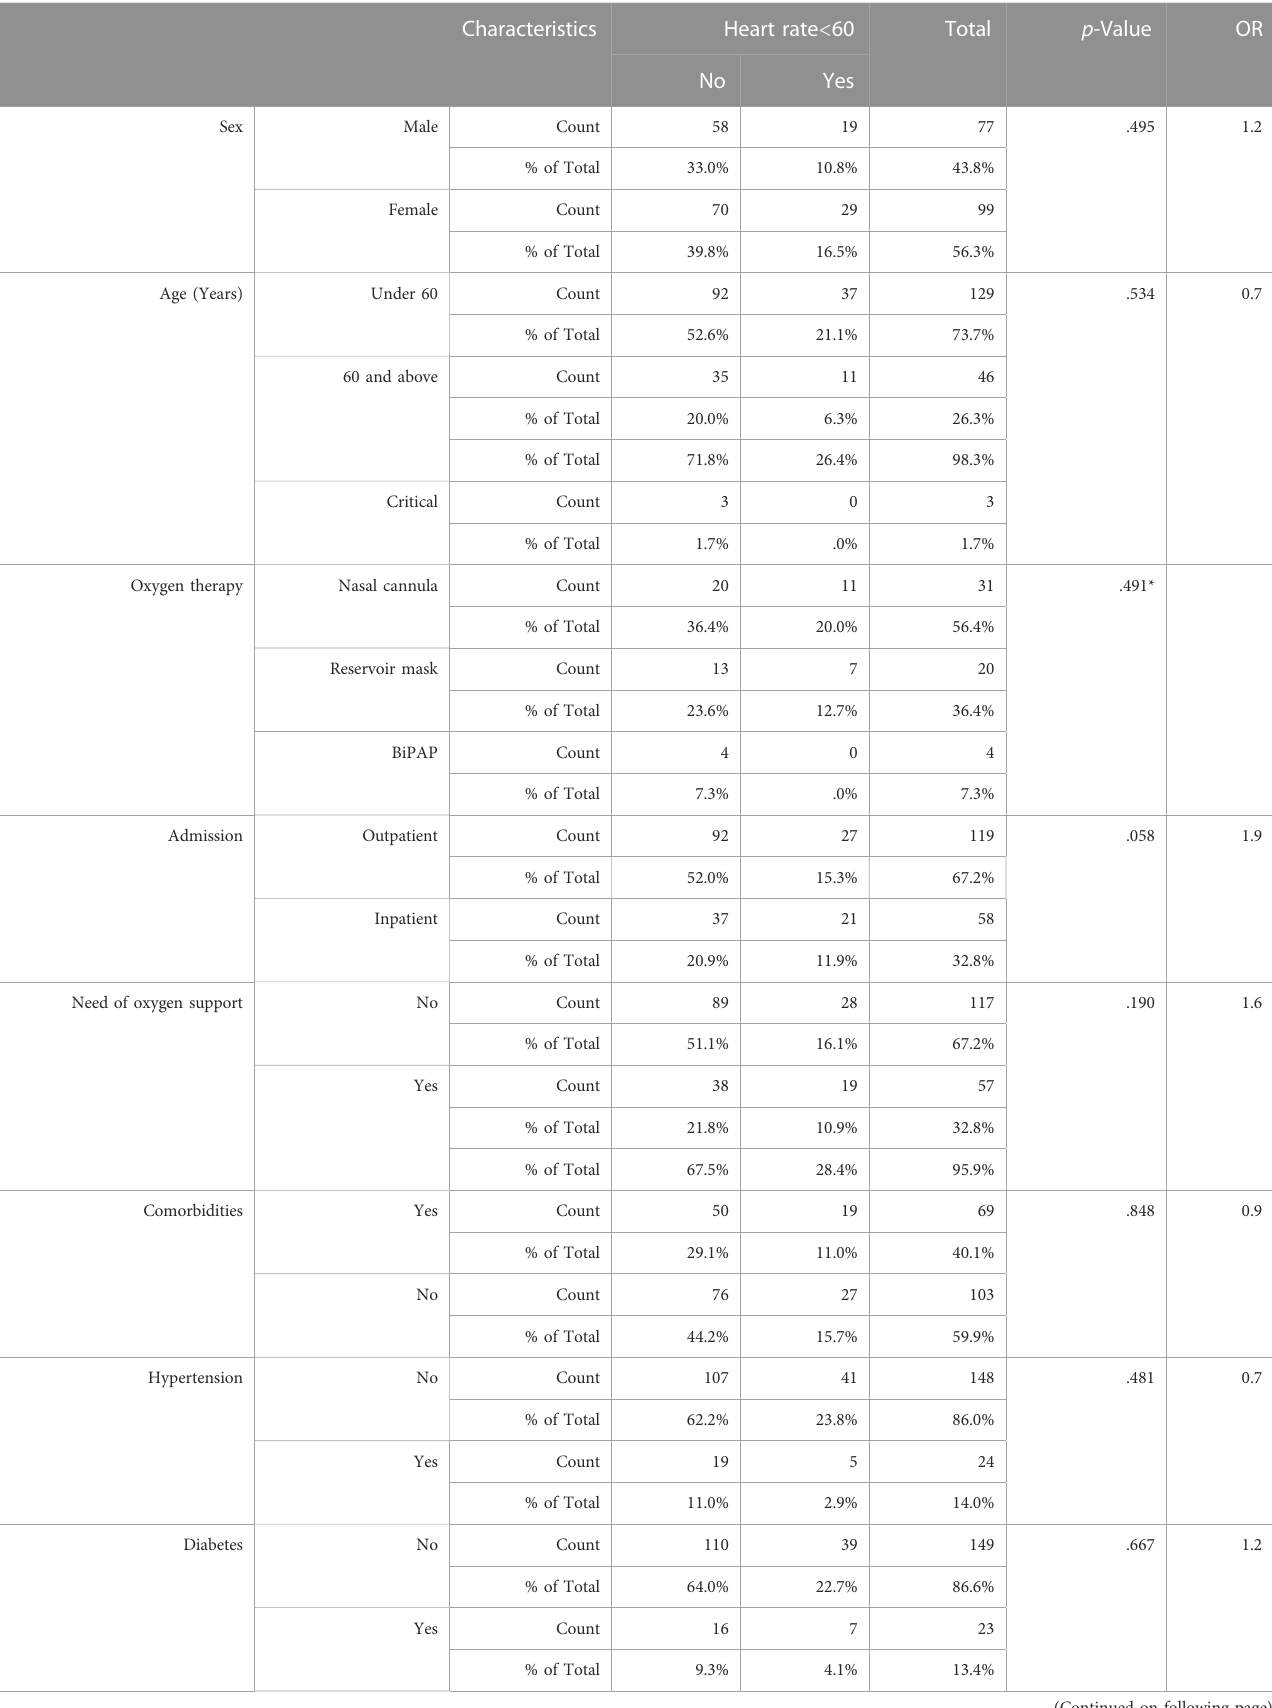
TABLE 2 Evaluating the association between qualitative variables and bradycardia using chi-square or fi sher ’ s exact test* and Odds ratio (OR) for measuring the strength (size) of association between them.